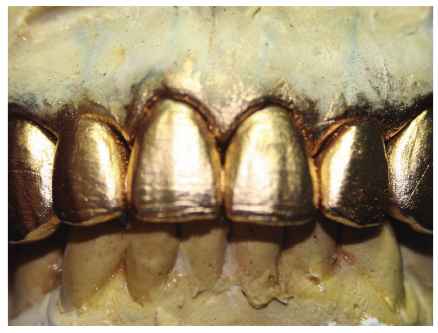
Figure 8: Surface texture reproduction with gold